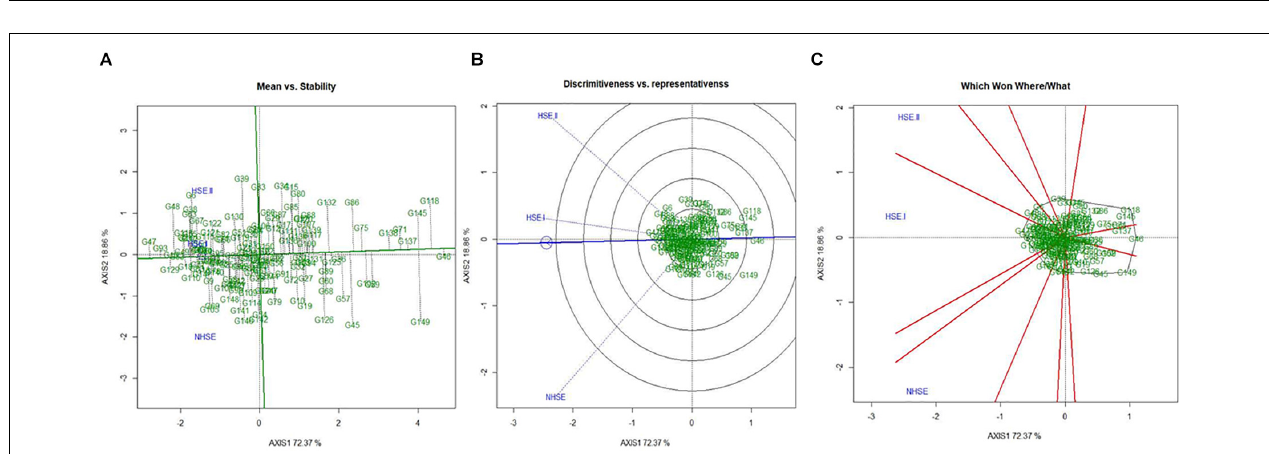
FIGURE 6 | GGE biplots developed by plotting the first and second principal components derived from the germination value of late-maturing genotypes of field pea evaluated in three environments (NHSE, HSE-I, and HSE-II). (A) “Mean versus Stability” view of genotypes. (B) Discriminating ability and representativeness of three environments, (C) which won where/what of field pea genotypes under different environments.